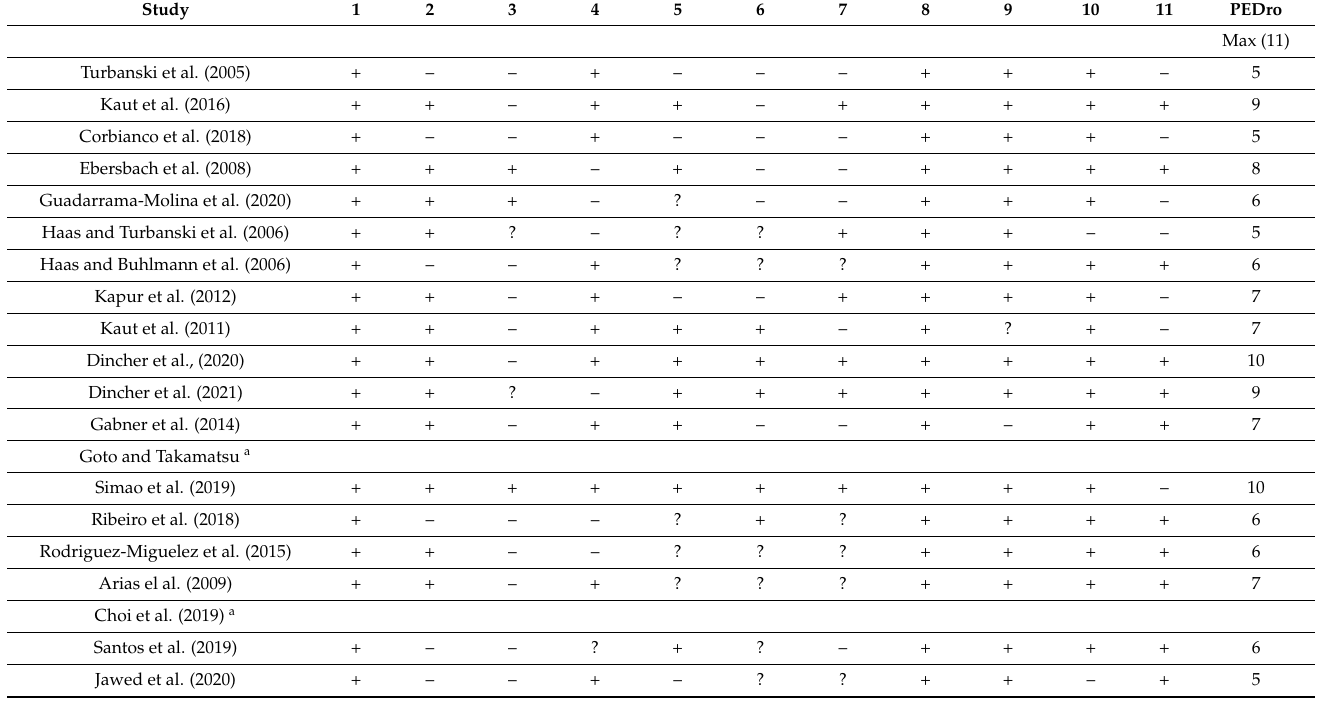
Table A2. Quality assessment of human studies included for qualitative analyses.